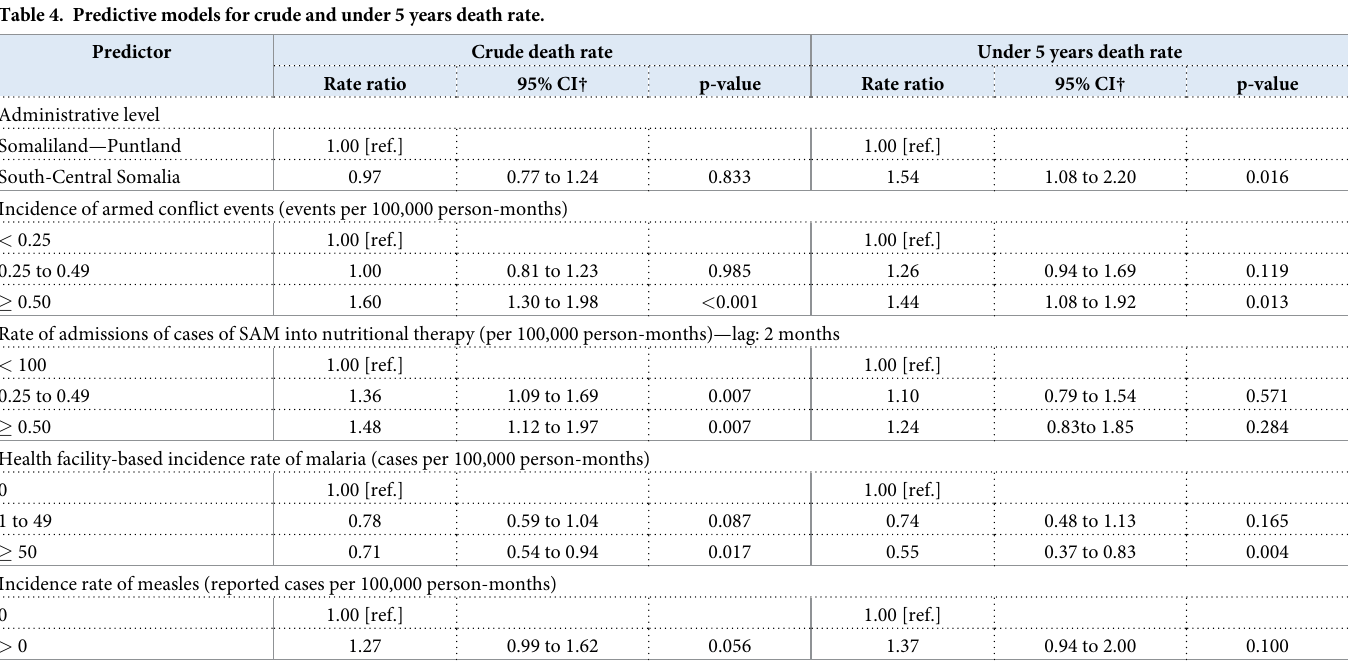
Table 4. Predictive models for crude and under 5 years death rate.